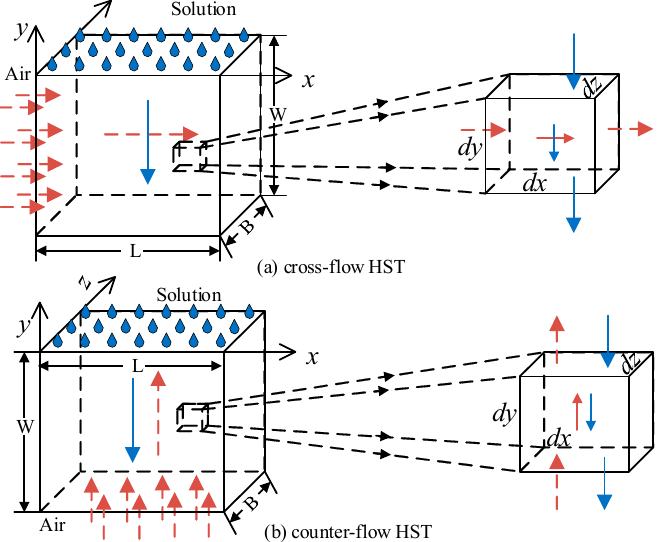
Figure 3. Schematic diagram of the cross-flow and counter-flow HST control volume.